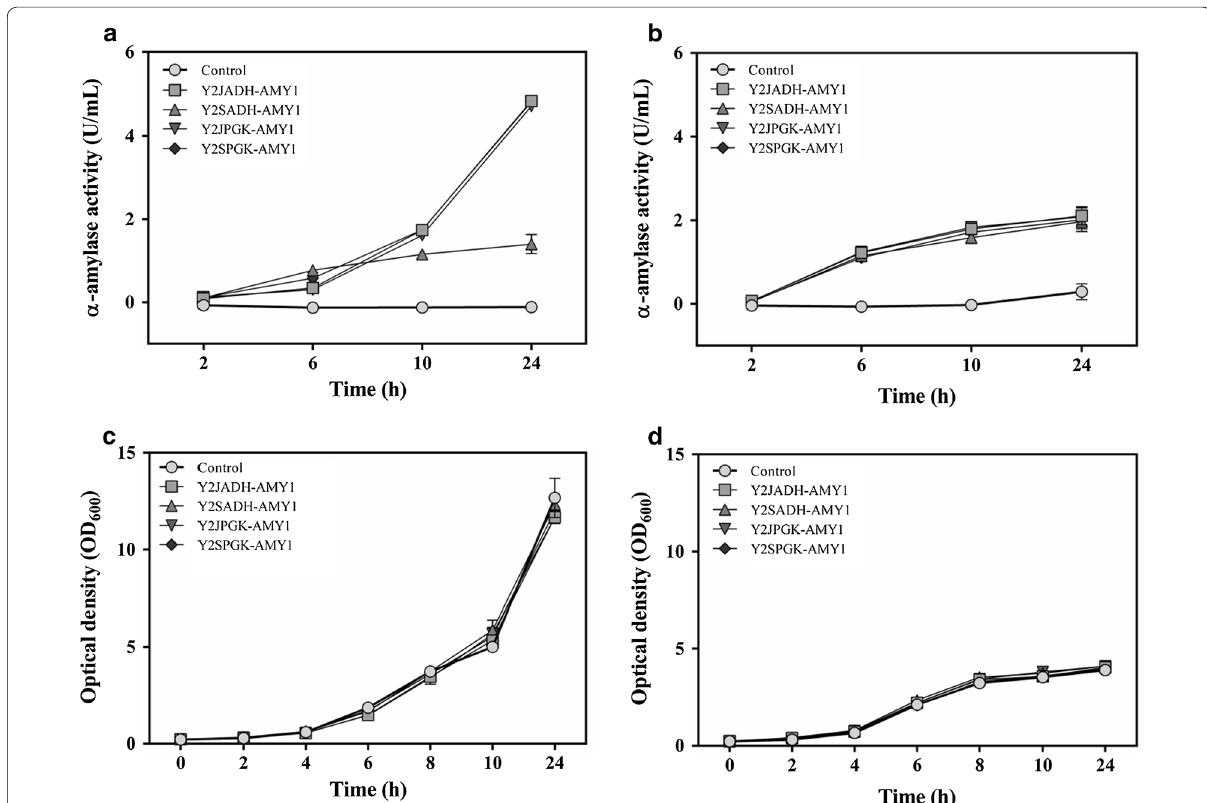
Fig. 4 Kinetics of α-amylase from C. flavus production by recombinant S. cerevisiae JPU and CEN.PK2 host strains. Amylase activity in JPU ( a ) and CEN.PK2 ( b ) strains, and growth curves of JPU ( c ) and CEN.PK2 ( d ) strains. The symbols represent: non-transformed cell ( circle ); Y2JADH-AMY1 ( square ); Y2SADH-AMY1 ( triangle ); Y2JPGK-AMY1 ( inverted triangle ); Y2SPGK-AMY1 ( diamond ). The error bars represent the standard error of biological and experimental